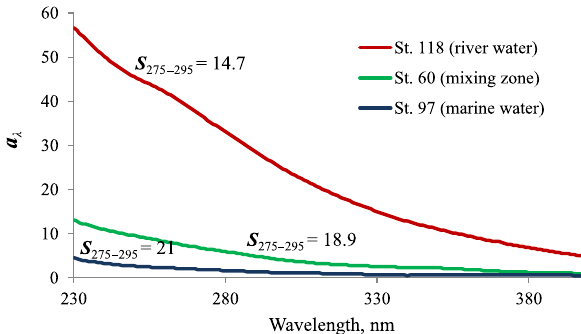
Figure 5. Surface CDOM absorption coefficient spectra a λ (m − 1 ) for stations (St.) 118, 60, and 97, September 2004; see Fig. 1 for location of